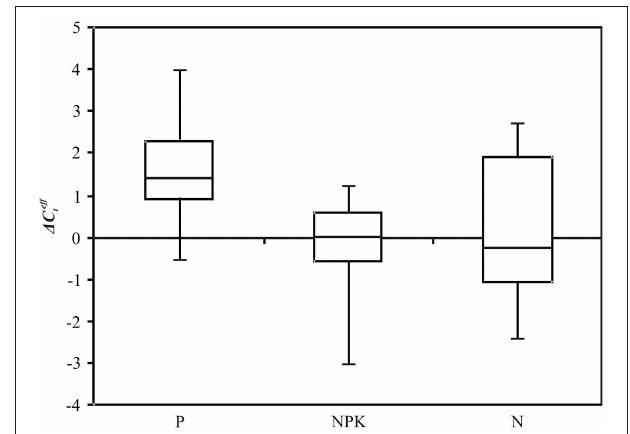
FIGURE 6 | Expression level ( 1 C eff t ) of lus-miR-N1 under Pi deficiency (P), excess nutrients (NPK), and normal (N) conditions. QPCR data. Rectangles correspond to the ranges containing 50% of the values (between the 25th and 75th quartiles); the horizontal line inside the rectangle is the median value (the 50th percentile); the bars are the maximum and minimum 1 C eff t